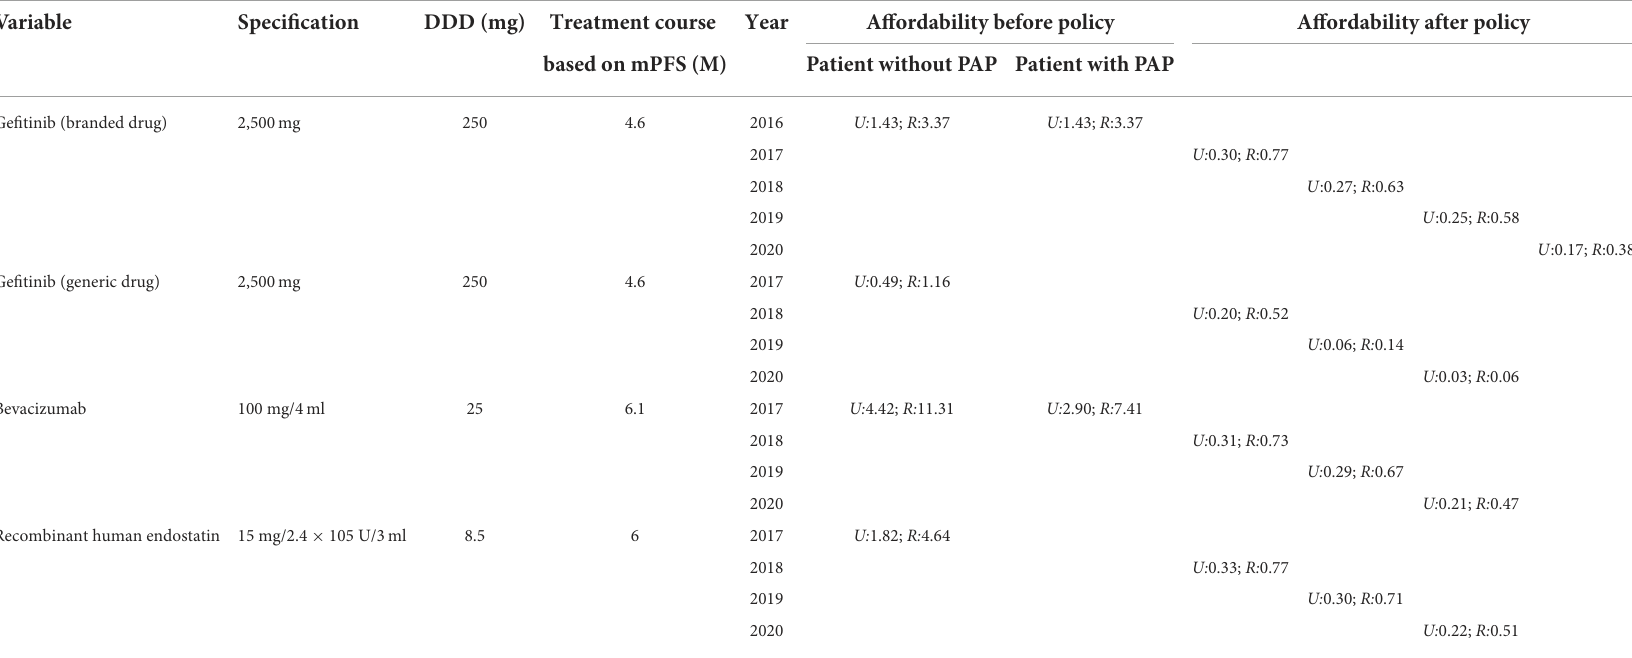
TABLE 3 The change in patient affordability for mPFS treatment courses before and after the pricing